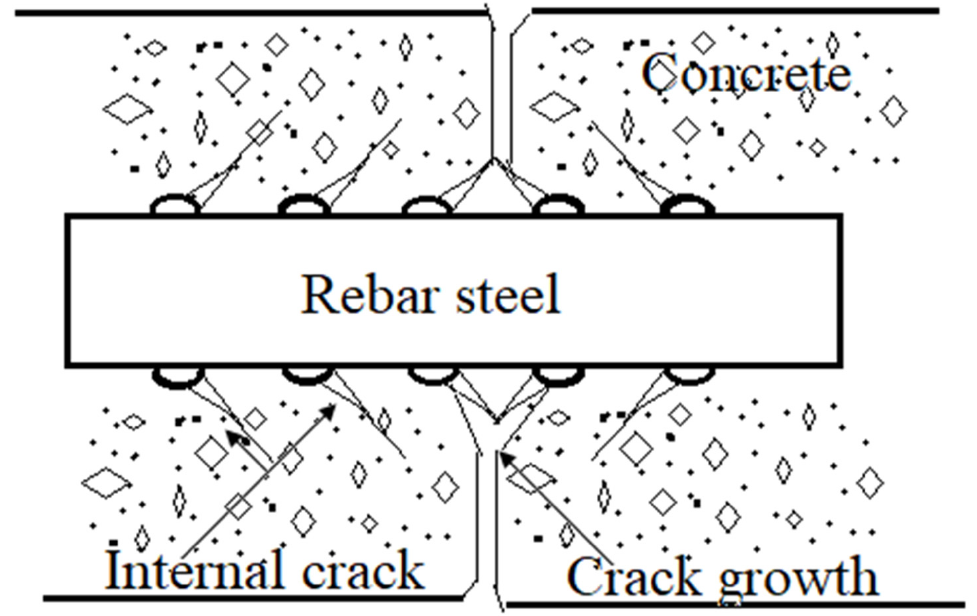
Figure 4. Initiation and propagation of cracks in reinforced concrete [74].